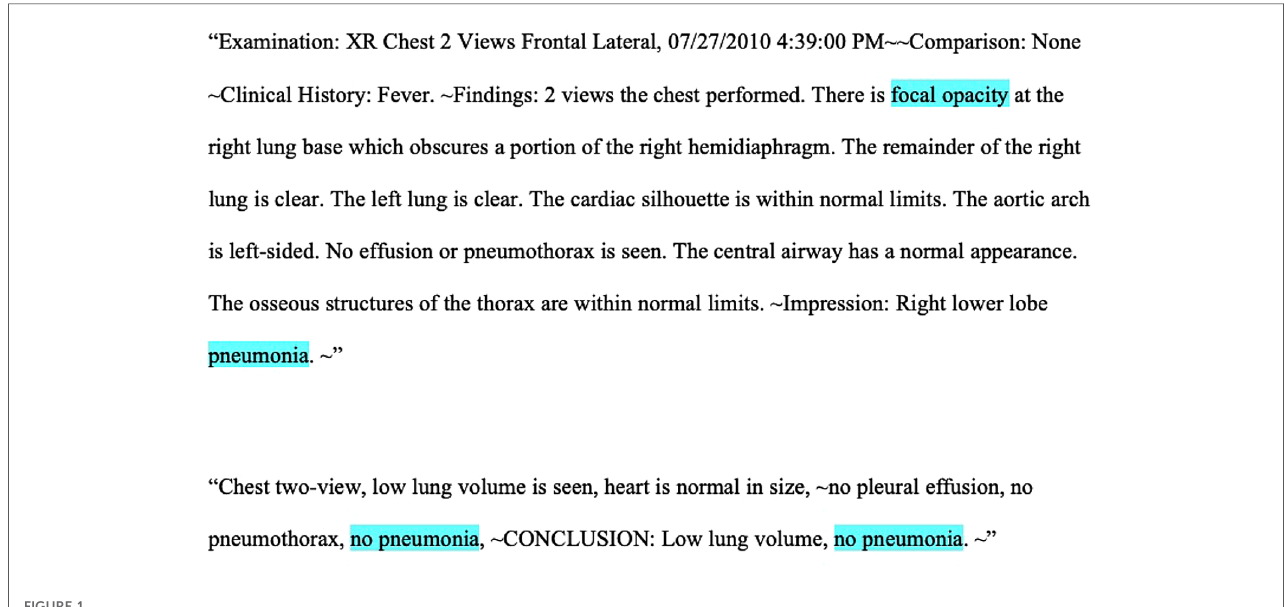
FIGURE 1 Highlighted examples of positive and negative chest radiograph reports,